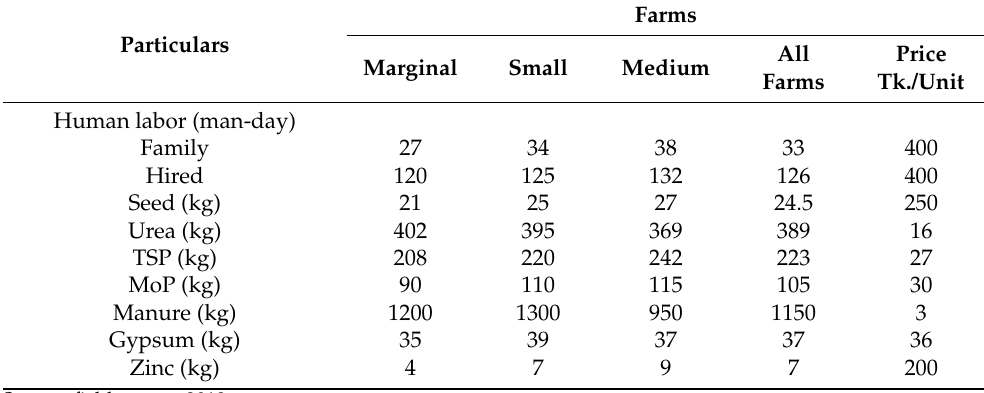
Table 2. Level of input use per hectare of maize cultivation. Particulars